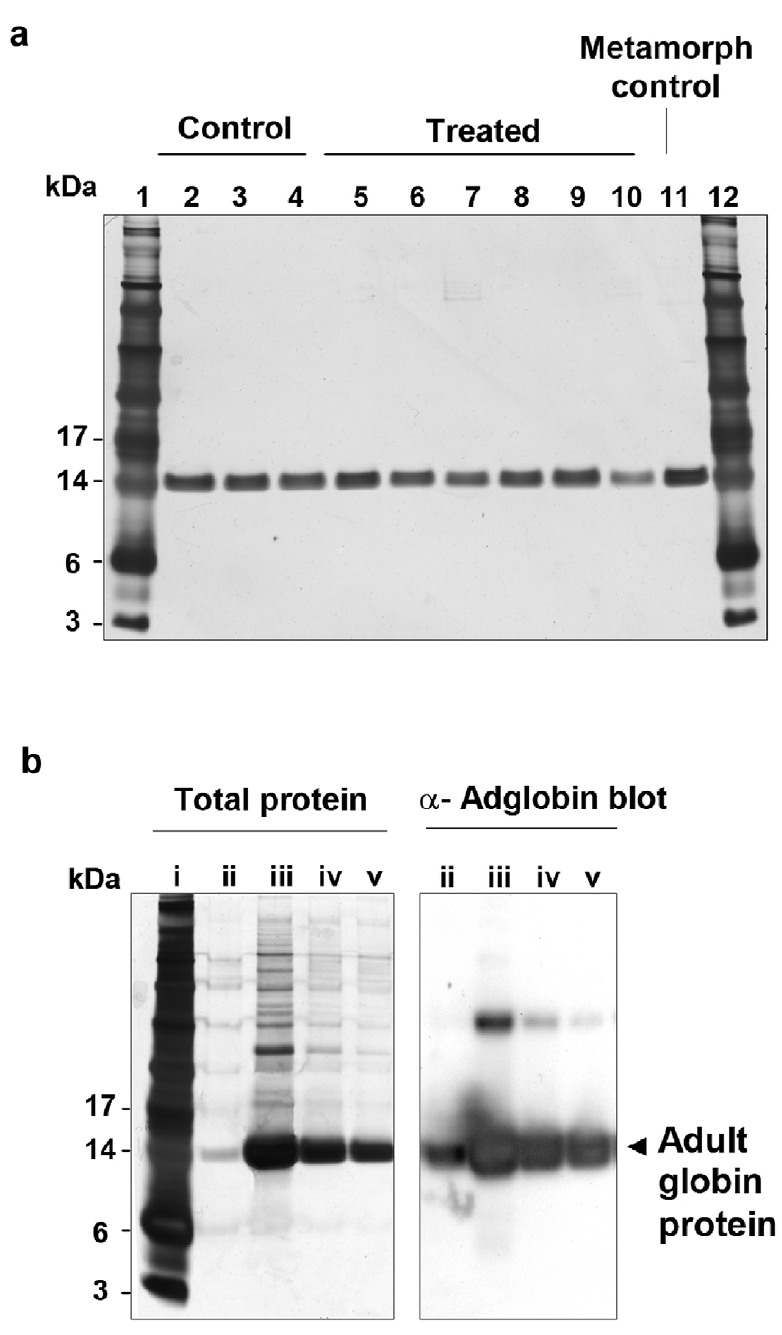
Figure 6. No effect on globin protein profile following infection of tadpoles with virus carrying rAdglob. 200 ng protein per well from lysed red blood cell samples taken from metamorphs then stained with silver stain. a: Lanes 1 and 12, See Blue Plus2 Pre Stained Standard (Invitrogen); Lanes 2–4, blood from 3 control animals bathed in 10 2 TCID 50 /ml of rBIV/neo r ; Lanes 5–10, blood from 6 test animals bathed in 10 2 TCID 50 /ml of rBIV/neo r /adglo. Lane 11, positive control, globin from a 2 month old toadlet. b: Panel shows silver stain and Western blot antibody detection of adult globin; lane i See Blue Plus2 Pre Stained Standard (Invitrogen); lane ii, positive control, globin from a 2 month old toadlet; lanes iii, iv and v, 500, 1000 and 5000 ng of protein from fluid of untreated stage 42 tadpoles.